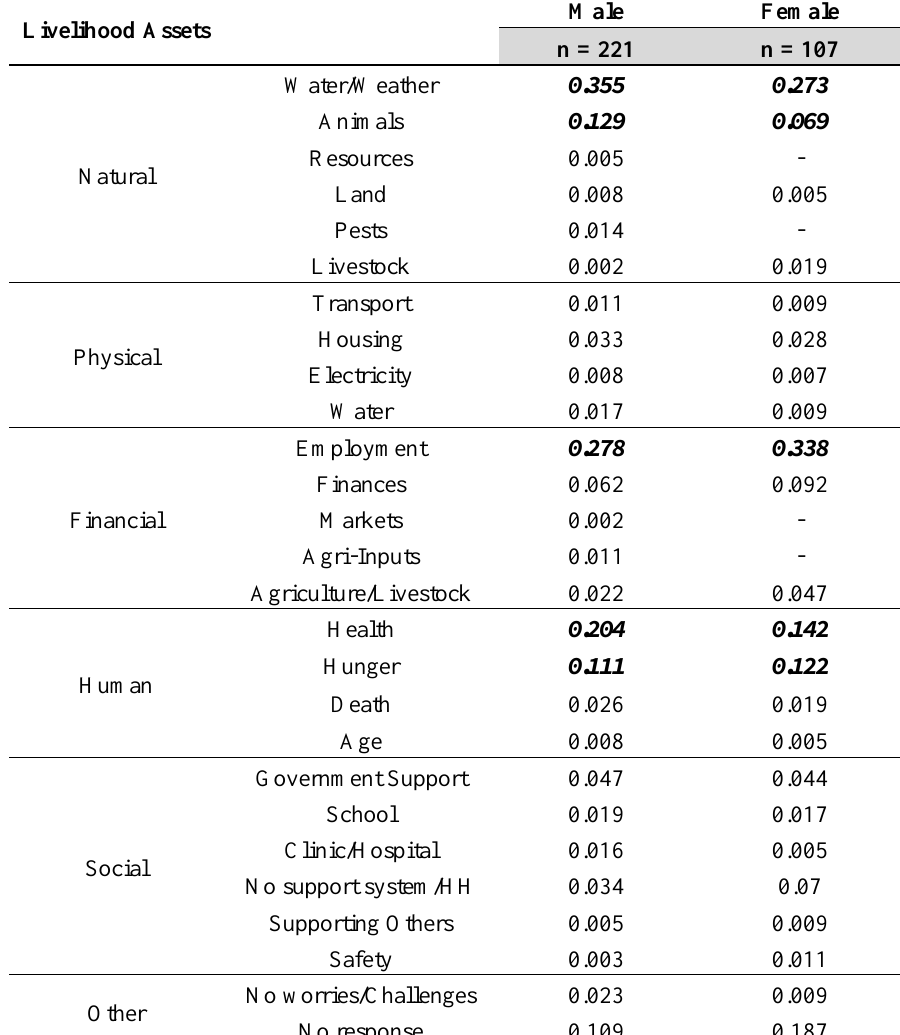
Table 5. Risk index values subset by gender. Where n refers to the number of households surveyed in each